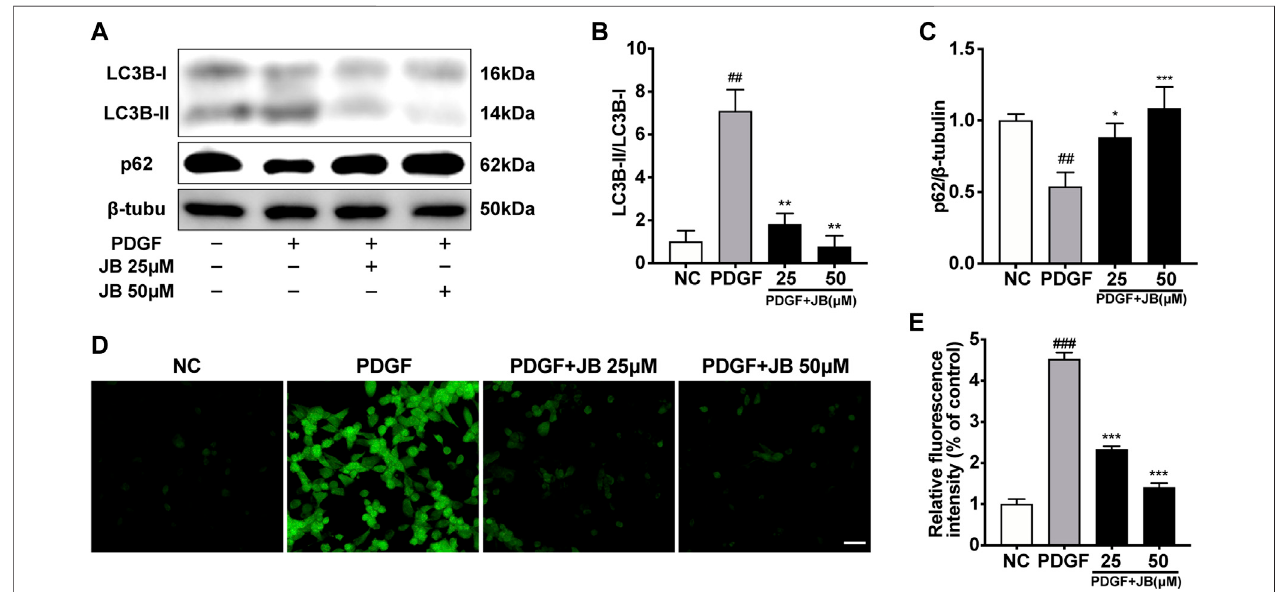
FIGURE 6 | JB attenuated the autophagy and ROS generation evoked by PDGF-BB in VSMCs. (A) Western blotting analysis of LC3B, p62 in VSMCs. (B,C) Quanti fi cationofLC3B-II/I (B) ,p62 (C) proteinexpressionlevelsbetweengroups. (D,E) ROSgenerationwasevaluatedbyDCFH-DA fl uorescence (D) andquanti fi cation ofrelativeROS fl uorescenceintensity (E) .Scalebar:100 μ m.Dataareexpressedasmean ± S.D. ## p < 0.01and ### p < 0.001vs.Control.* p < 0.05,** p < 0.01and*** p < 0.001 vs. PDGF-BB group. n (cid:1)